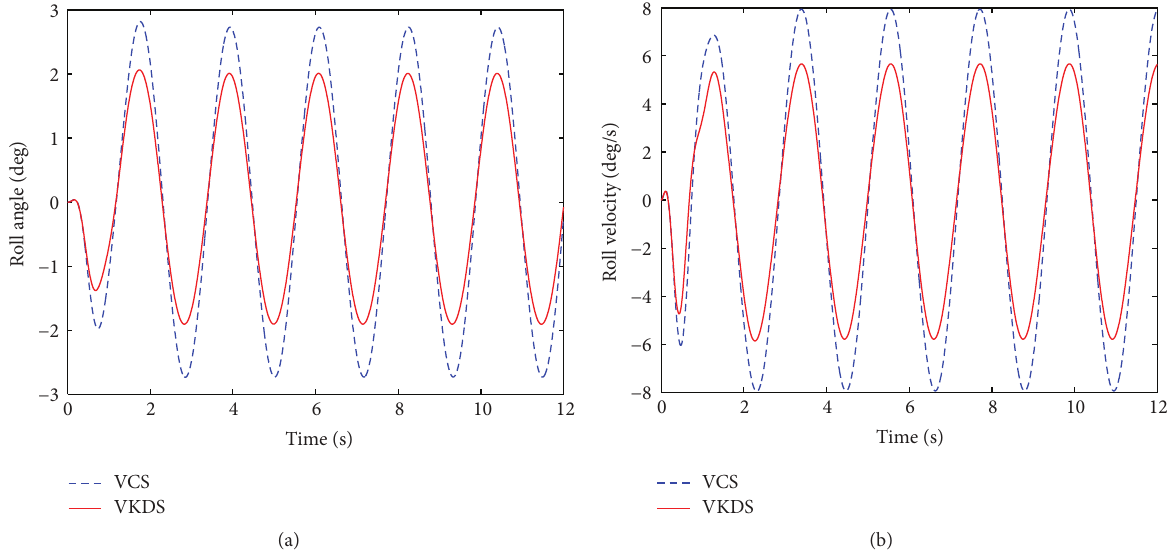
Figure 8: (a) Sprung mass roll angle of the VCS and VKDS under the slalom test. (b) Sprung mass roll velocity.